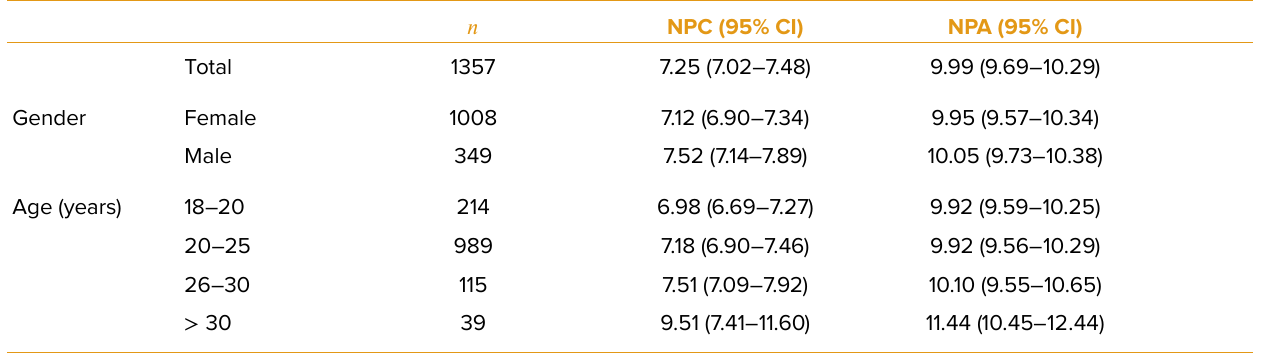
Table 1. The mean near point of convergence and near point of accommodation